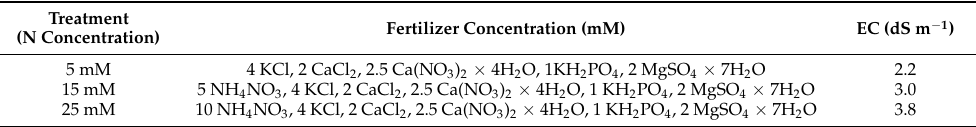
Table 1. Fertilizer content in the nutrient solution of each